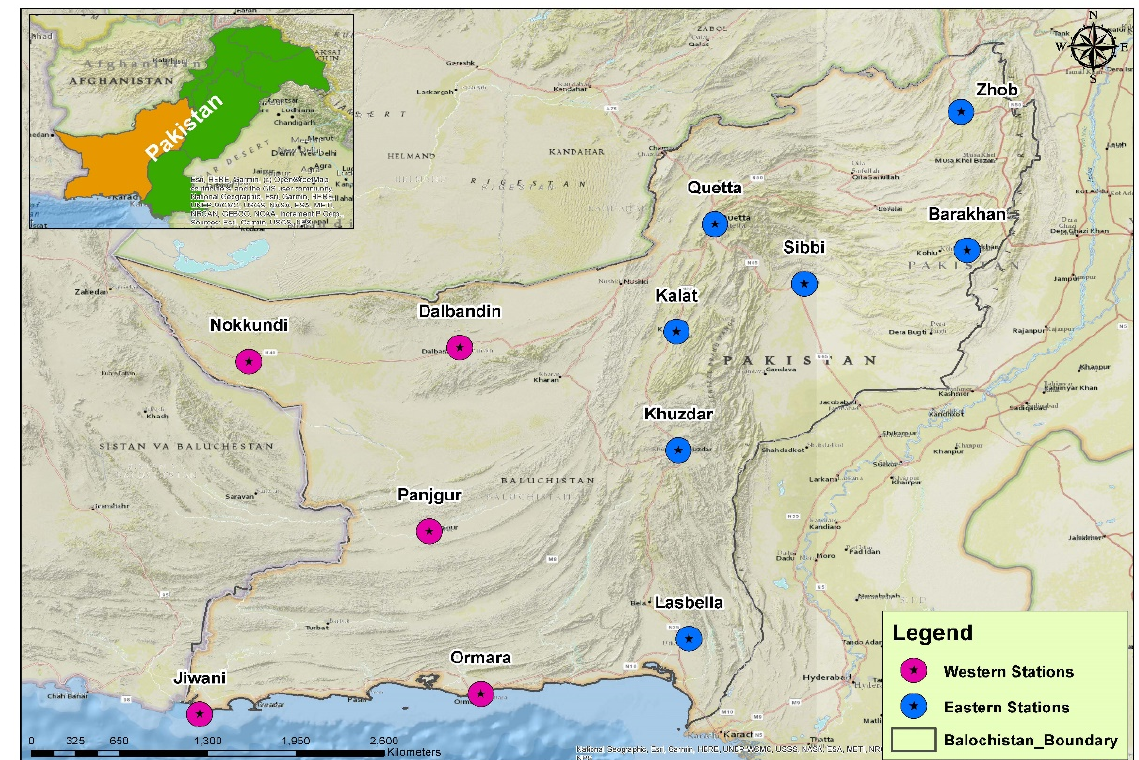
Figure 1. The location map of the selected PMD stations in Baluchistan (figure courtesy of the PMD).